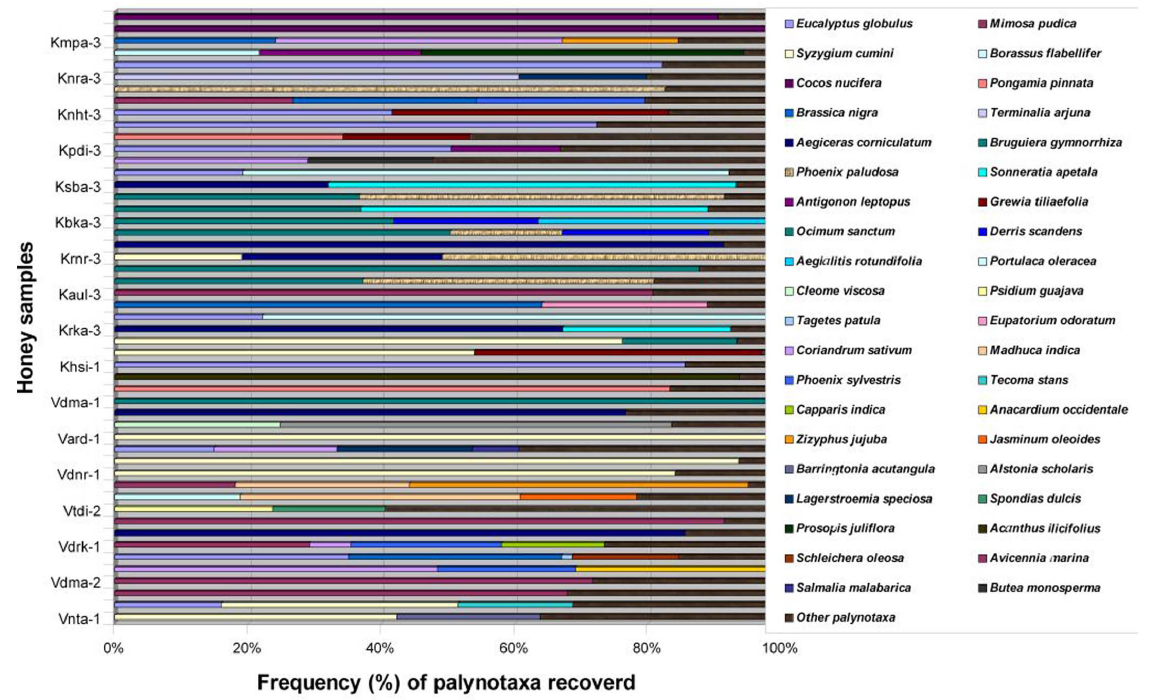
Figure 2. Frequency (%) of palynotaxa recovered.